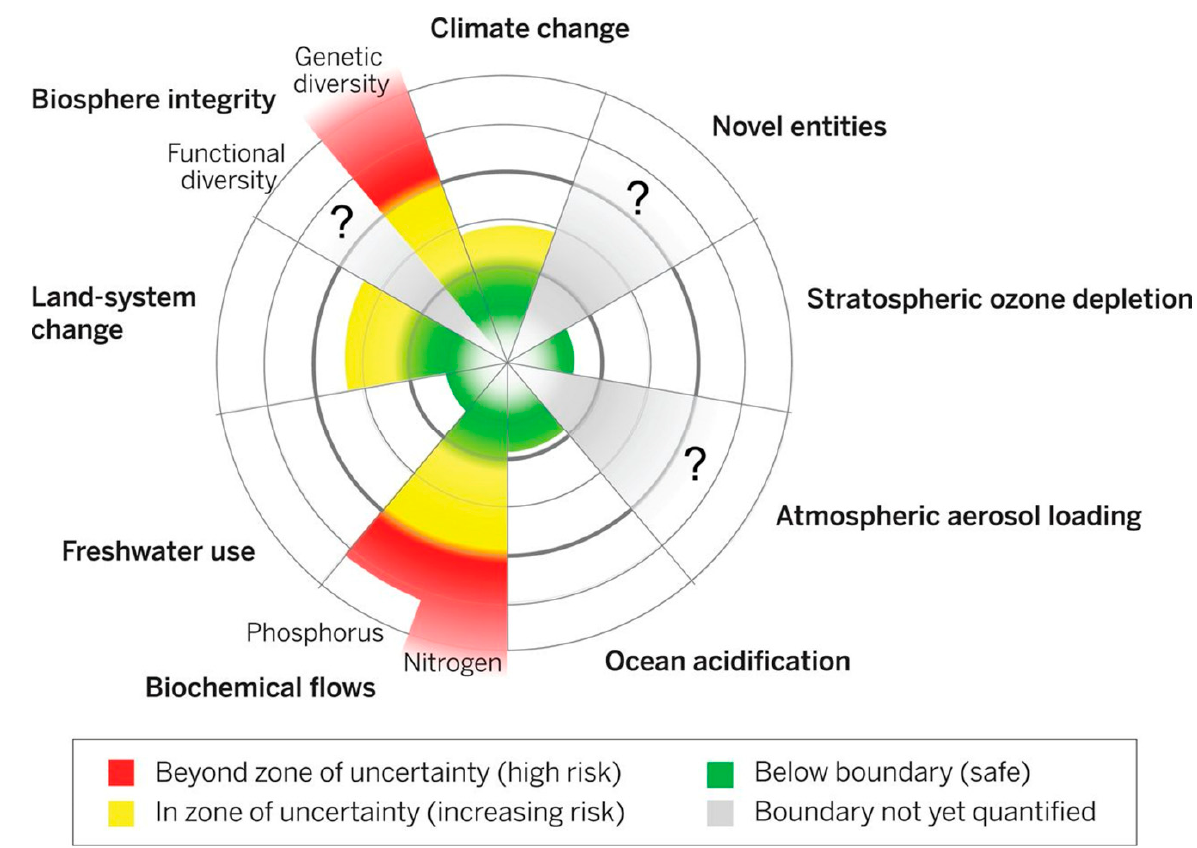
Figure 6. Current status of planetary boundaries control variables [26]. The control variables describe the different anthropogenic perturbations from stable Earth systems. Different levels of risk range from safe, to not yet quantified or increasing, to high risk. The intersection of the below boundary (safe) and in zone of uncertainty (increasing risk) defines the planetary boundary. From [26]. Reprinted with permission from AAAS.